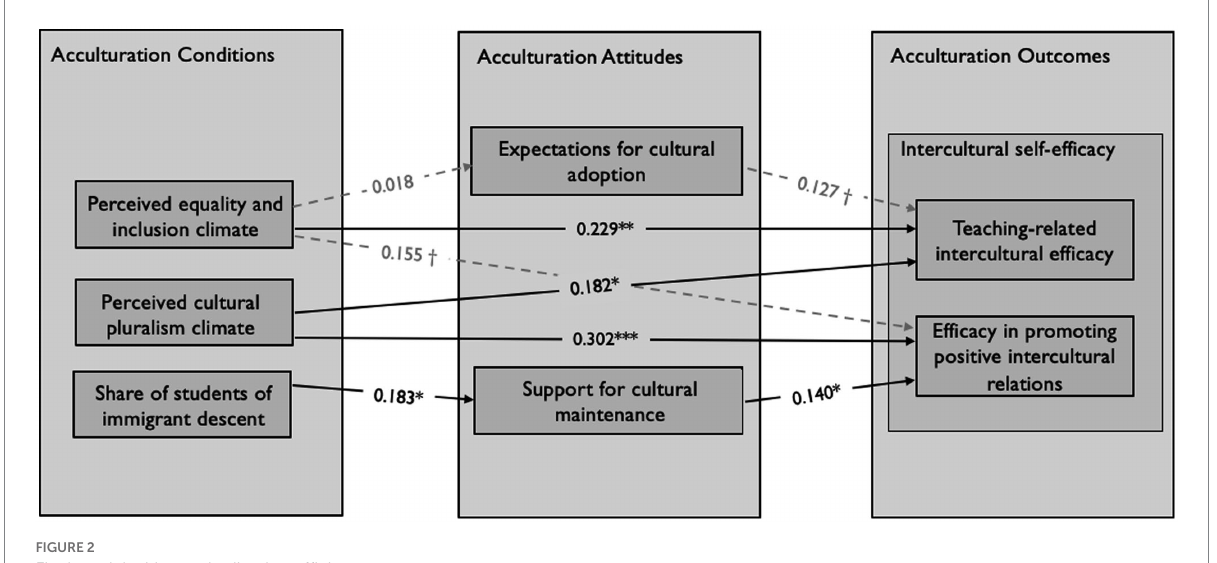
FIGURE 2 Final model with standardized